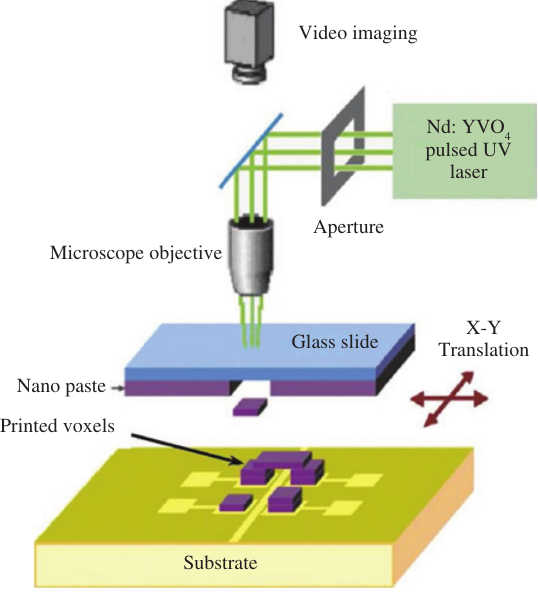
Figure 22: Schematic view of the LIFT setup. Reprinted from [112].